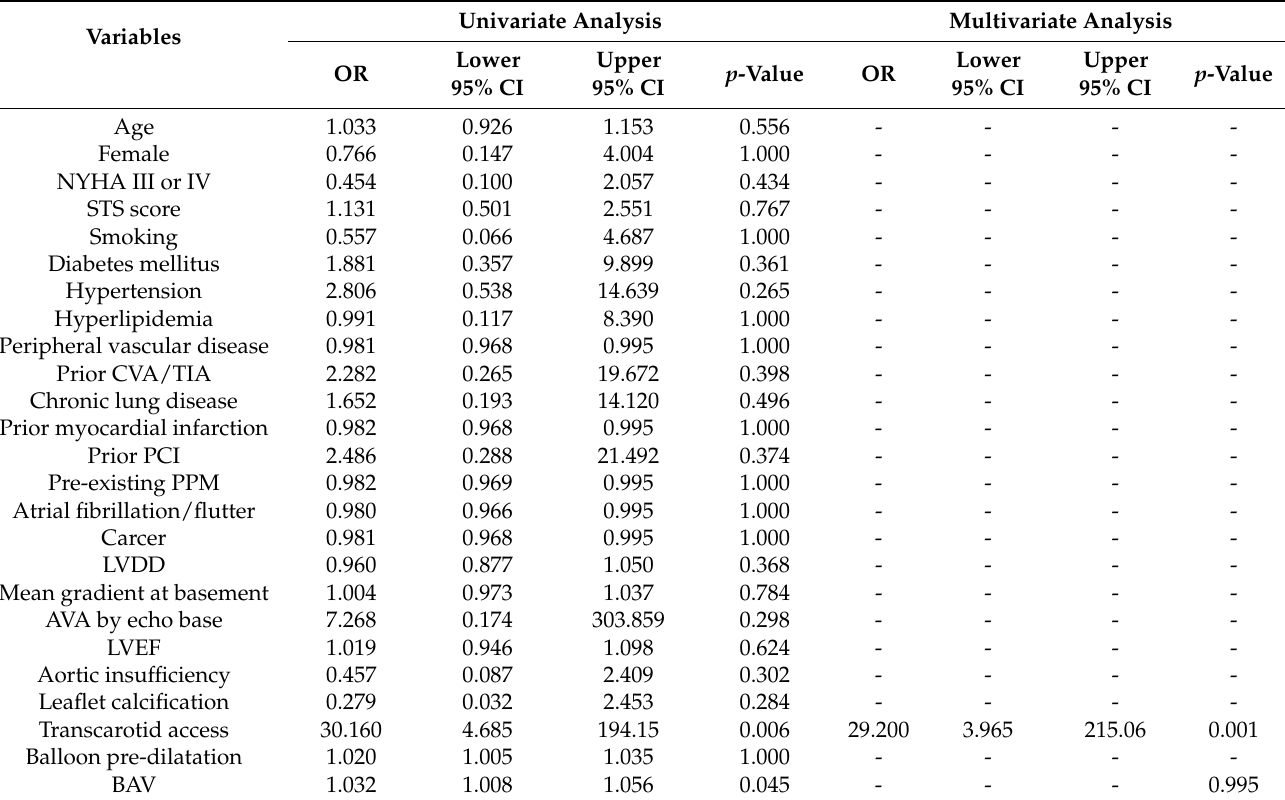
Table 4. Univariate and Multivariable Predictors of All Stroke After